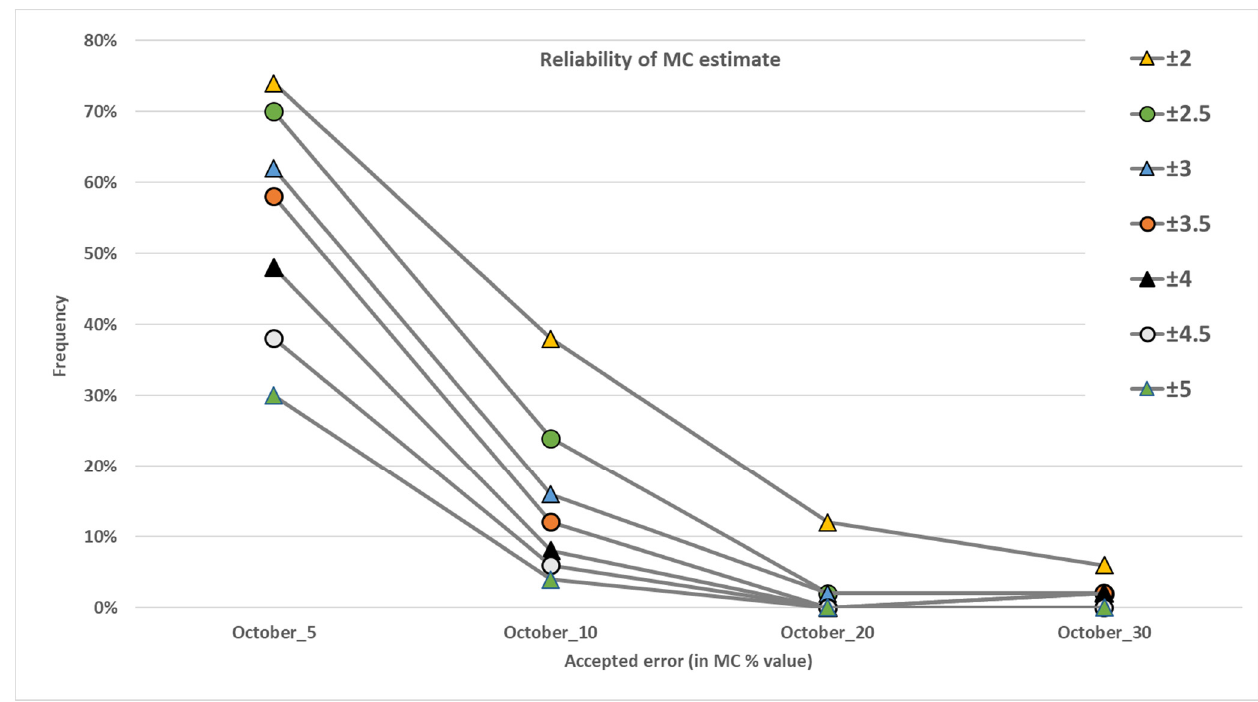
Figure 9. Sensitive analysis of MC estimation accuracy of the Summer pile based on the average of an increasing number of samples (5, 10, 20 and 30). Trend lines show the result according to different error tolerance levels.